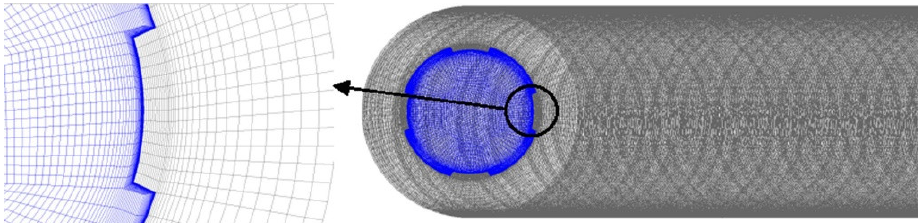
Figure 6. Physical structure of the rifled tube [76]. Reprint with permission from ref. [76]. Copyright 2018 Elsevier.